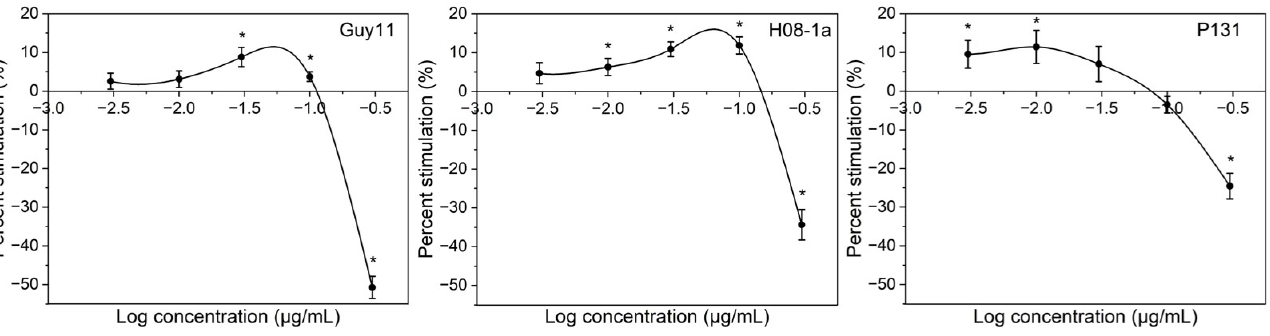
Figure 1. Stimulatory effects of carbendazim in PDA on the mycelial growth of Magnaporthe oryzae . Error bars represent the standard errors of mean values in independent experiments. Asterisk indicates significant difference ( p < 0.05) between the treatment and the control.